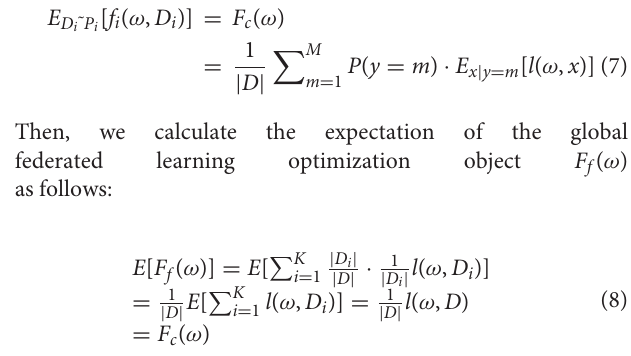
Frontiers in Plant Science |